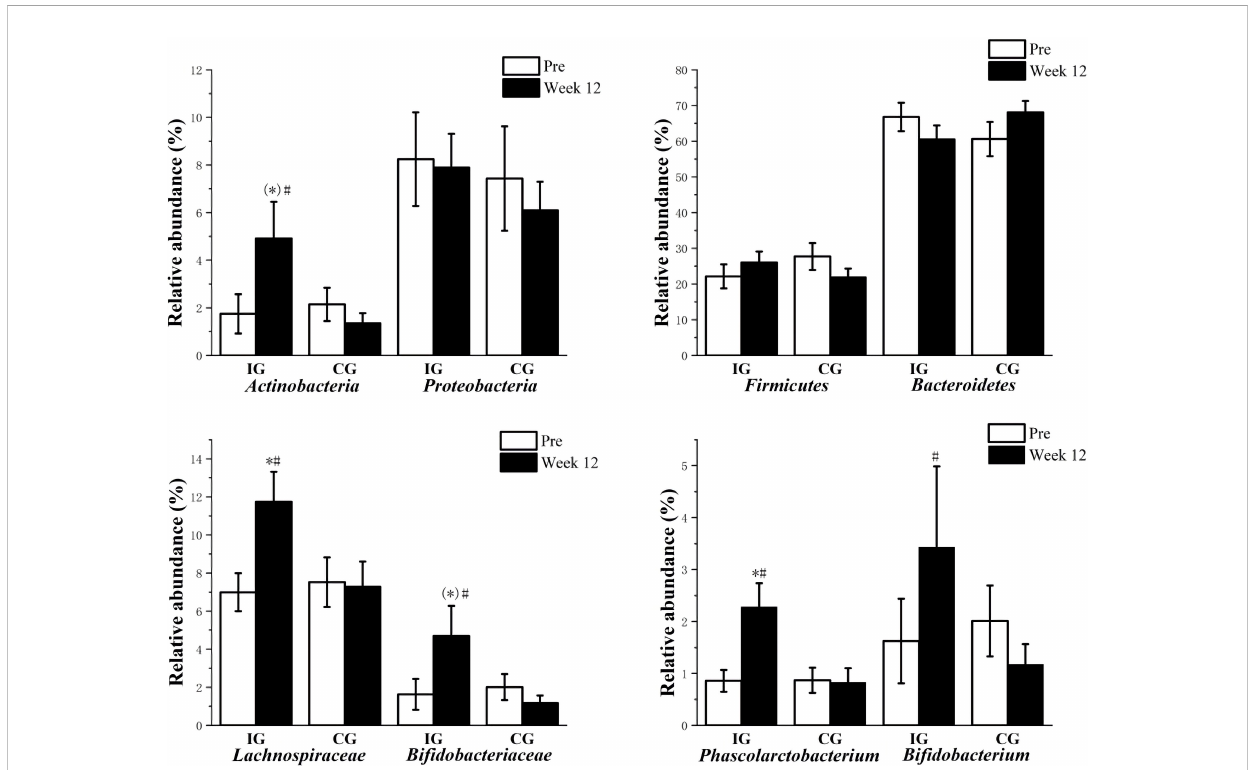
FIGURE 2 Changes in gut microbiota in two groups (mean ± SEM). # : P <0.05 vs. Pre, *: P <0.05 vs. CG, (*): 0.05< P <0.1 vs. CG; SEM, standard error of mean; CG, control group; IG, intervention